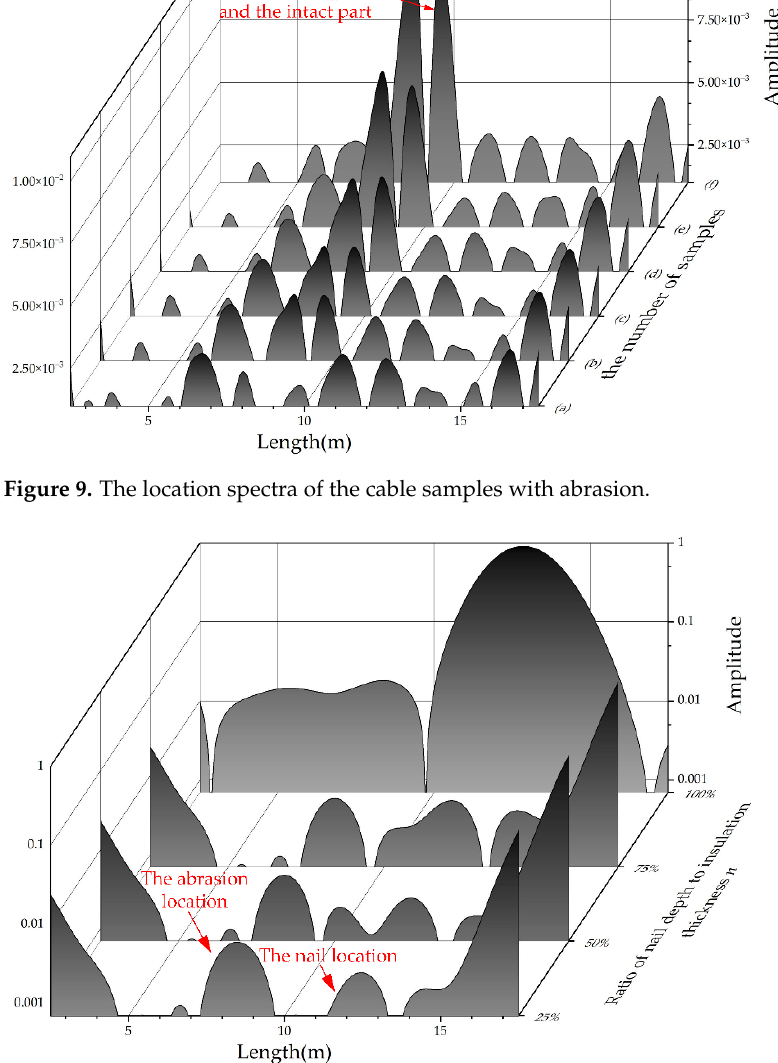
Figure 9. The location spectra of the cable samples with abrasion.